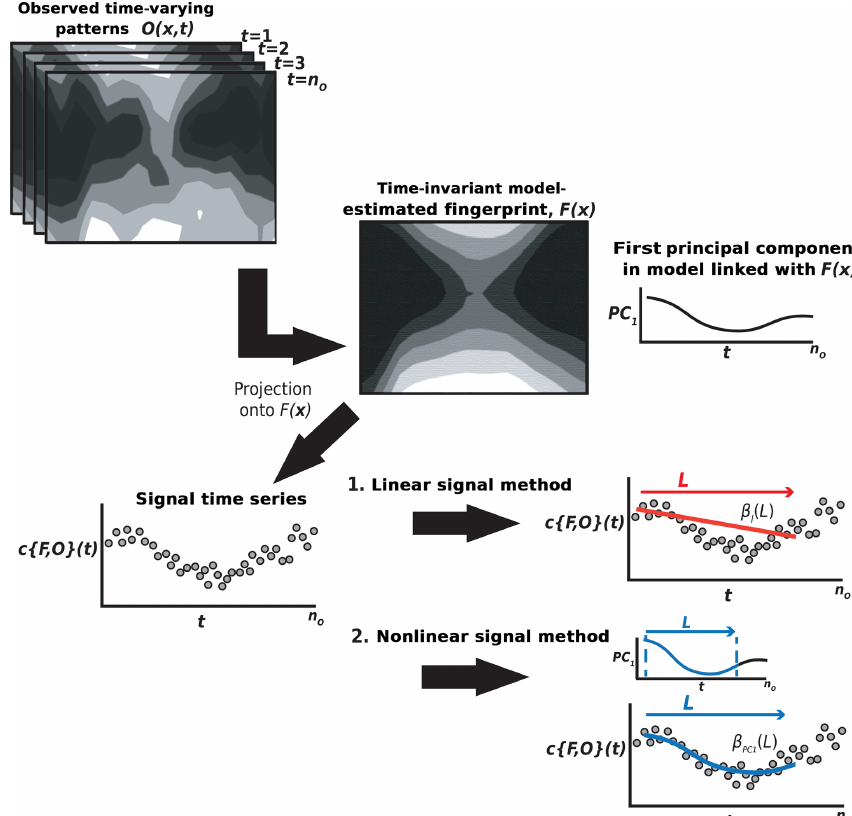
Figure 9. Schematic of the linear and nonlinear signal methods used for fingerprint identification. O(x,t) denotes the observed time- varying patterns of zonal-mean ozone anomalies; x is an index over the spatial dimensions (latitude and pressure). F(x) is the searched-for fingerprint – the leading empirical orthogonal function of the zonal-mean ozone response in the ODSonly, GHGonly, or ALL1 simulation. For each of the three fingerprints, there is an associated leading principal component time series (PC 1 ) that spans the time period of the observational record. The observations are projected onto each fingerprint, yielding the signal time series, c { F,O } (t) . In the linear signal method, it is assumed that the time evolution of the fingerprint pattern is quasi-linear over the length of the observational record, and L -length linear regression coefficients are calculated between c { F,O } (t) and the time in years; these are the coefficients β l (L) . In the nonlinear method, the regression is between L -year segments of c { F,O } (t) and the model PC 1 of the corresponding fingerprint. These are (L) the regression coefficients β PC 1